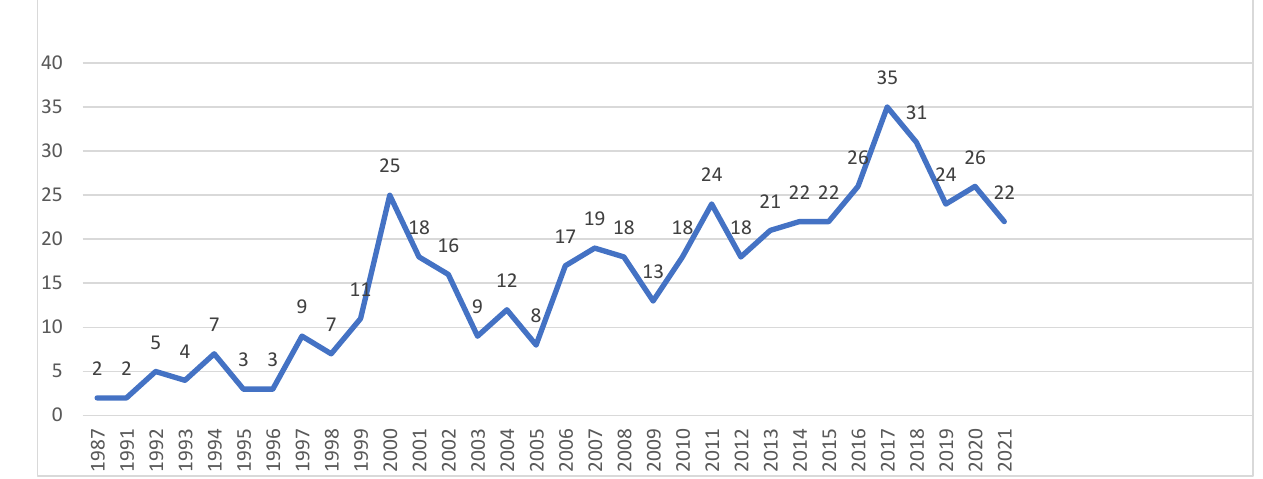
Figure 2. Trends of environmental valuation publications between 1987 and 2021.